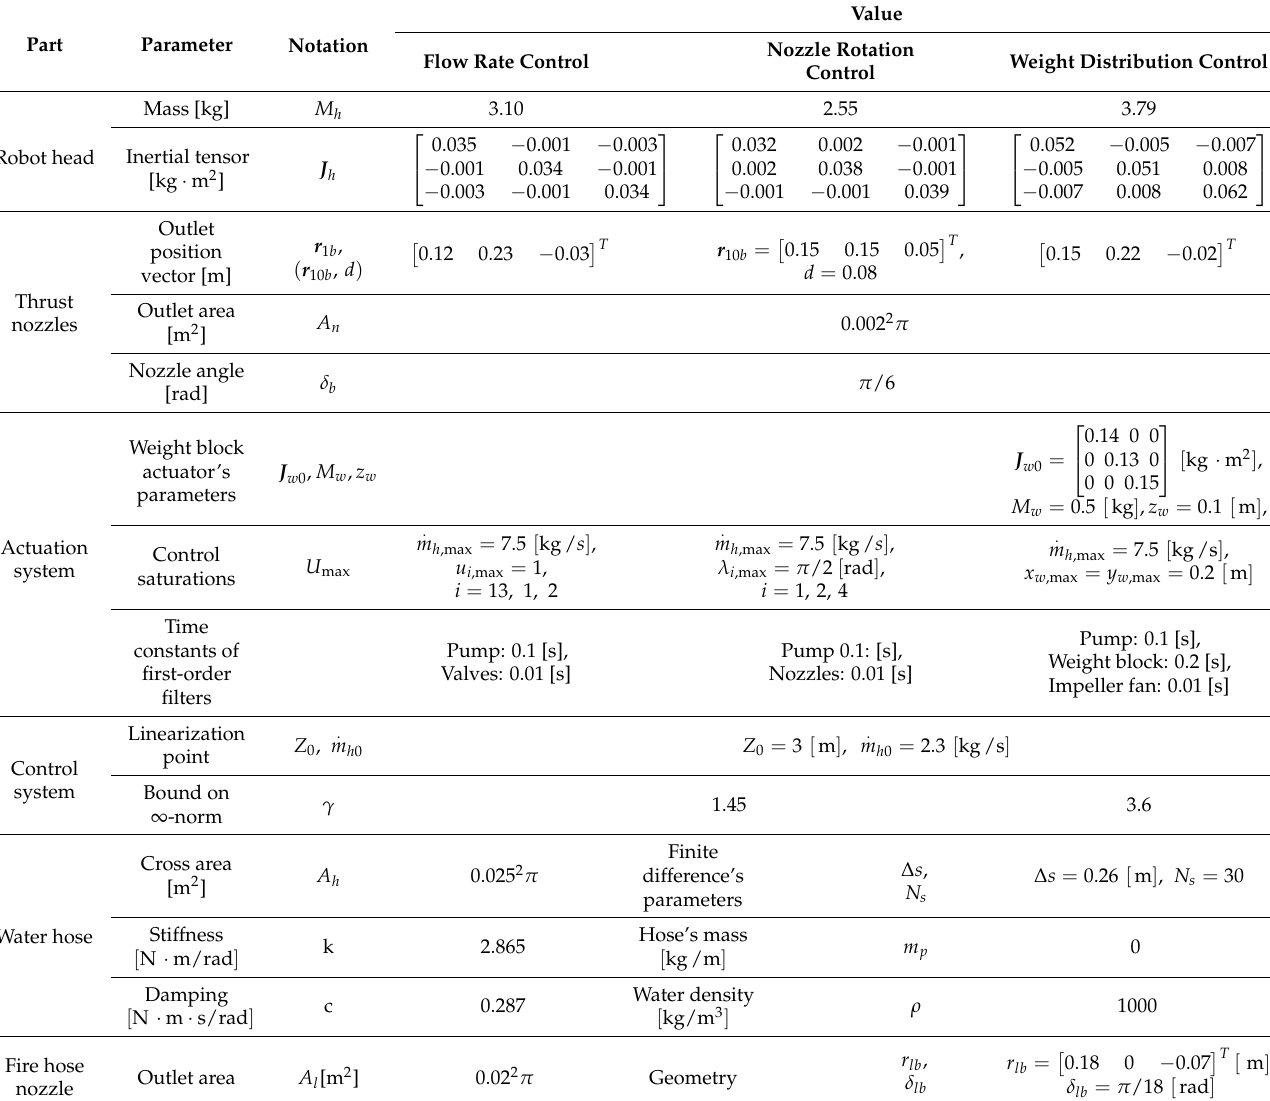
Table 1. Specifications of the designed